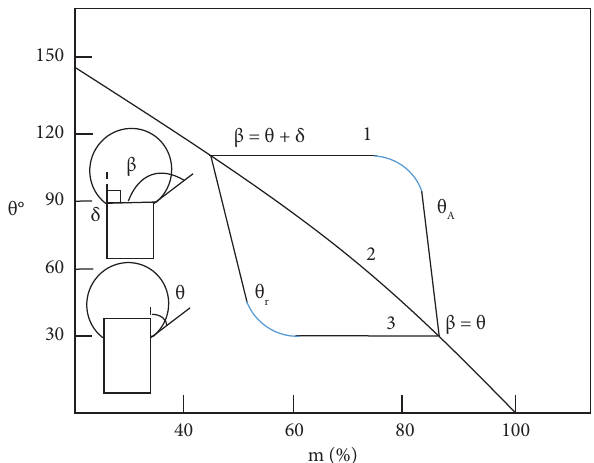
Figure 9: Schematic representation of the hysteresis dependence contact angle catalyst droplet on top of the NW for the Me-Si system of the proportion of the degree of wetting m of well- wetted areas.